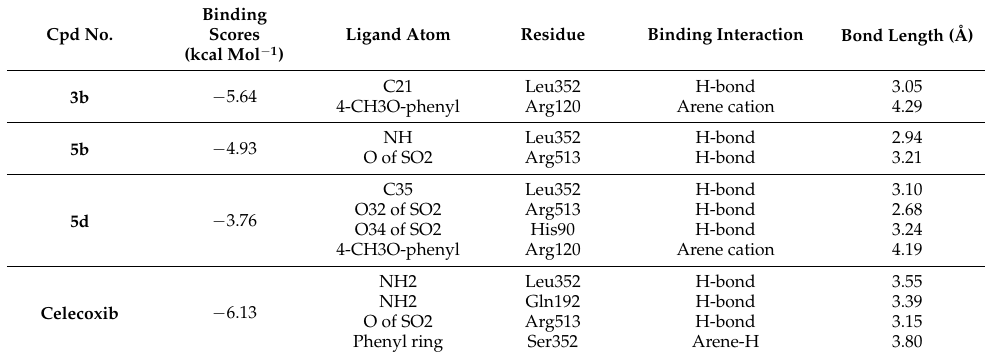
Figure 7. 3D interactions of the co-crystallized ligand Celecoxib (upper left panel), 3b (upper right panel), 5b (lower left panel), and 5d (lower right panel) with the active site of cyclooxygenase 2 (PDB ID code: 1CX2). Table 5. The data of the synthesized compounds 3b , 5b , 5d , and Celecoxib docking in COX-2 active sites. Cpd